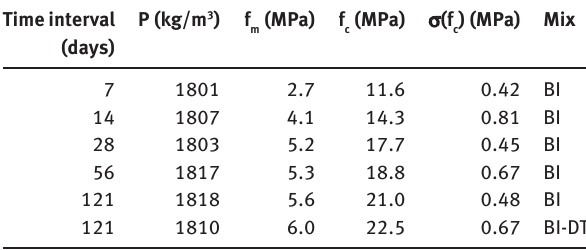
Table 5 Densities and mechanical properties of hardened fine grained concrete (mix BI and BI-DT).